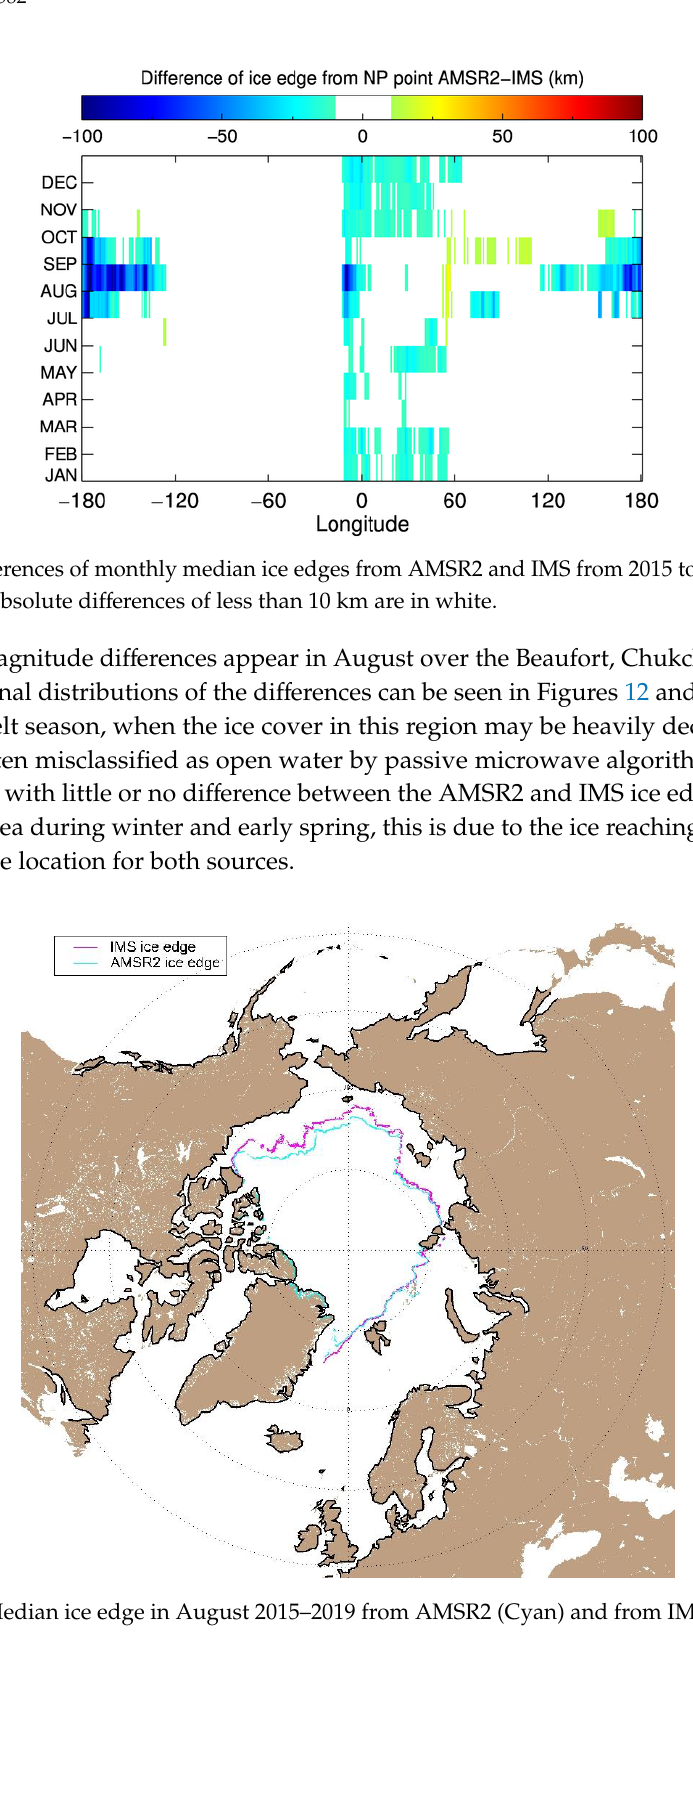
Figure 13. Longitudinal distribution of median ice edge from North Pole point in August from AMSR2 (Blue) and IMS (Green) 2015–2019. 4. Discussion and Conclusion In this study, the daily AMSR2 ice extent (based on a 15% concentration threshold) was assessed with IMS ice extent from July 2015 to July 2019. Four statistical scores on a daily basis, their monthly means, and annual cycles were calculated and shown. Subsequently, ice edges from the AMSR2 ice extent were compared to those from the IMS ice extent. Many algorithms are available to estimate the passive microwave ice concentrations, each with its respective strengths and weaknesses. In this study, the enhanced NASA Team (or NASA Team 2) algorithm was used. The IMS ice extent is based on human analysis of many near-real-time datasets, and thus, may provide more comprehensive ice